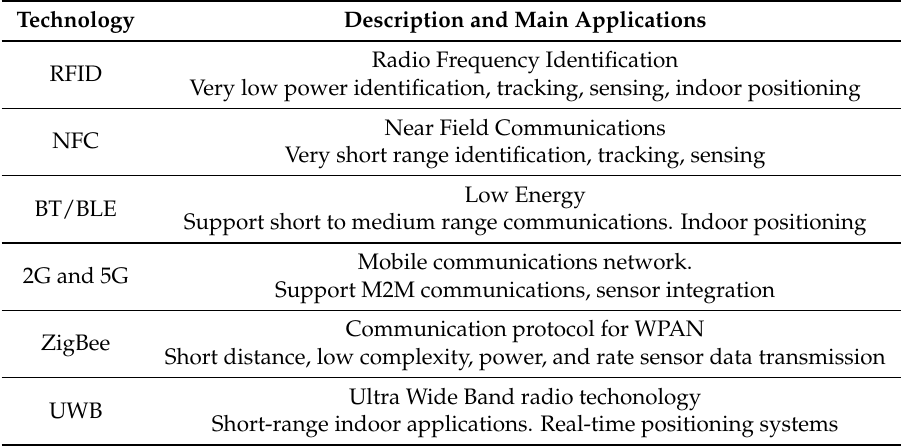
Table 2. Summary of several Internet of Things (IoT) wireless driving technologies and their main applications in a wireless sensor network